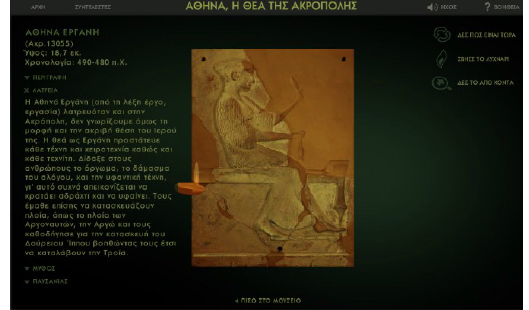
Figure 3: Exhibit from the online application “Athena, the Goddess of Acropolis”